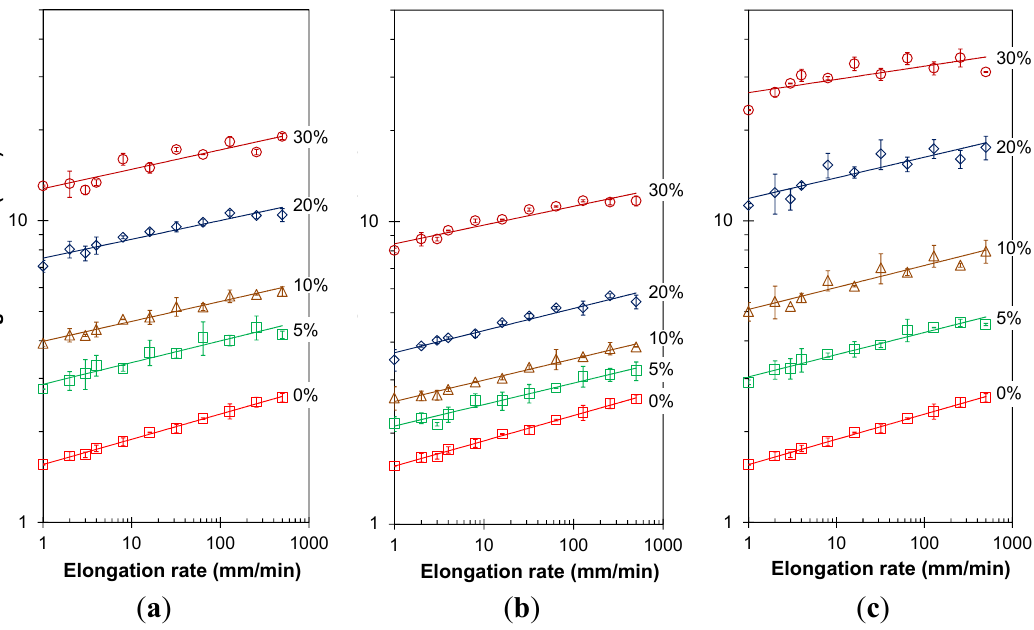
Figure 5. Young’s modulus as a function of the elongation rate for both neat EOC and EOC/CNTs or EOC/CFs composites. Sample length is 2 cm and width is 3 cm. ( a ) CNT; ( b ) ox-CNT; ( c ) CF. The solid lines represent the best fit of the experimental data with the power function given in Equation